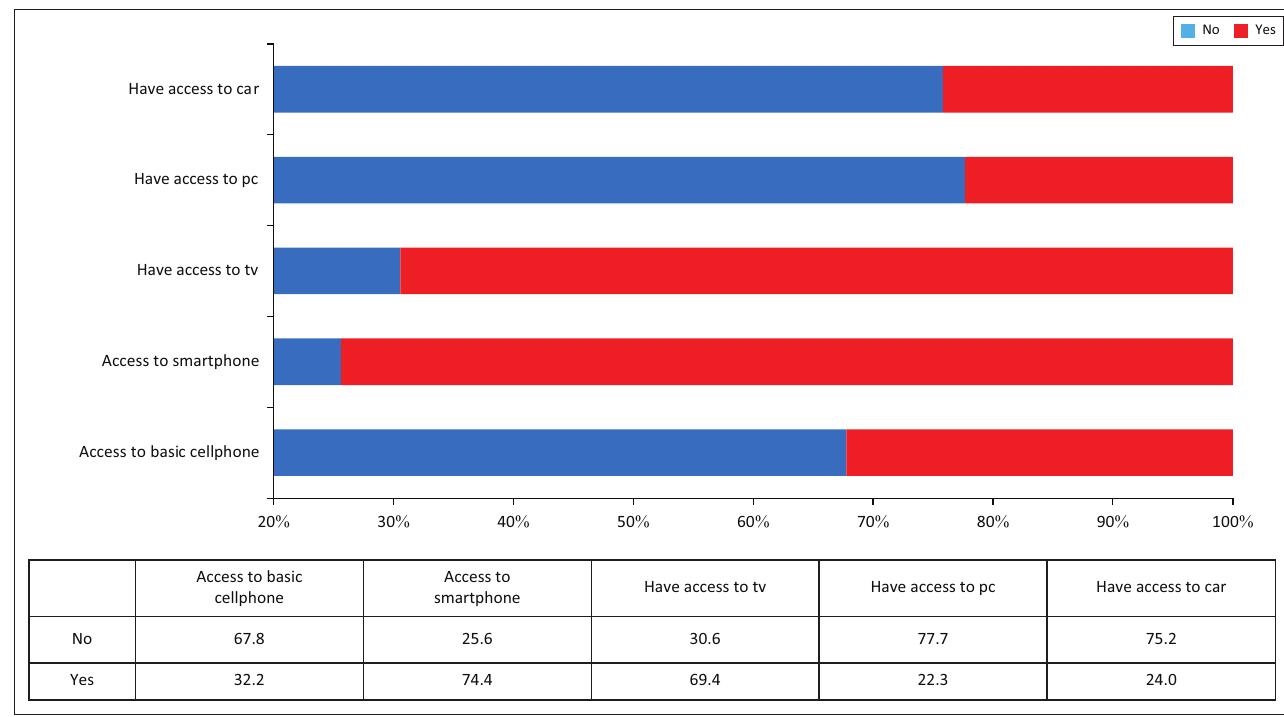
Table 1, census information just states that 81 % of people in